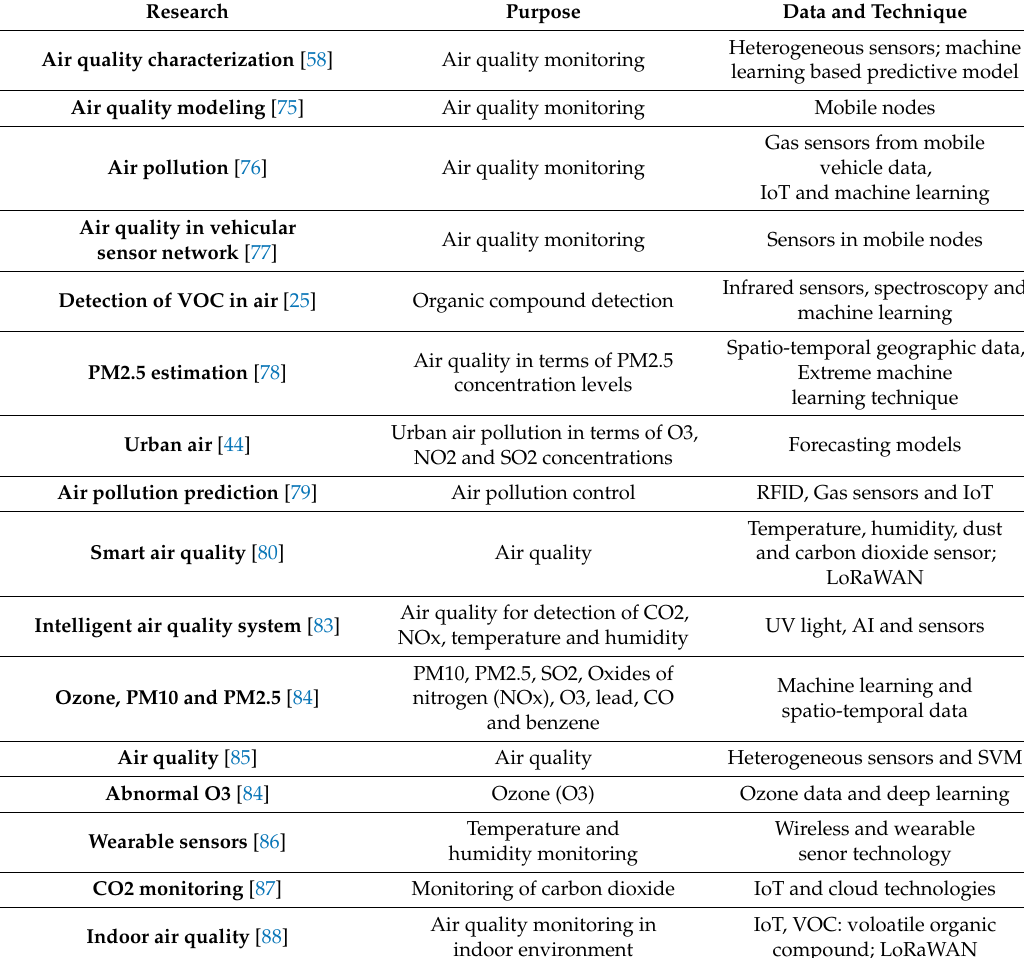
Table 4. Research on SAQM systems using machine learning and